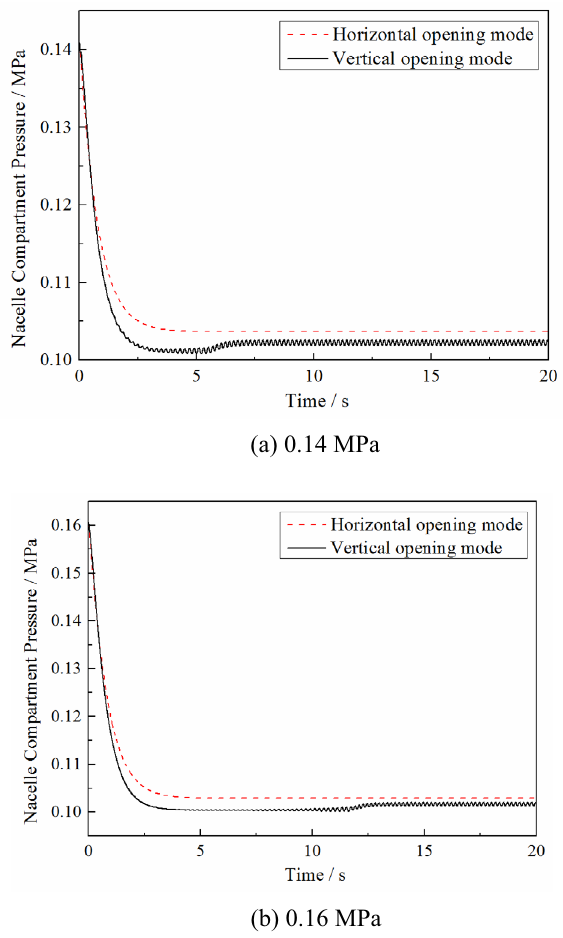
Figure 3. Effect of different opening modes on the nacelle compartment pressure changes under different opening